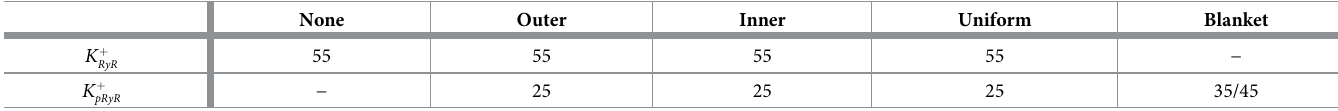
and K þ used for the RyR pRyR